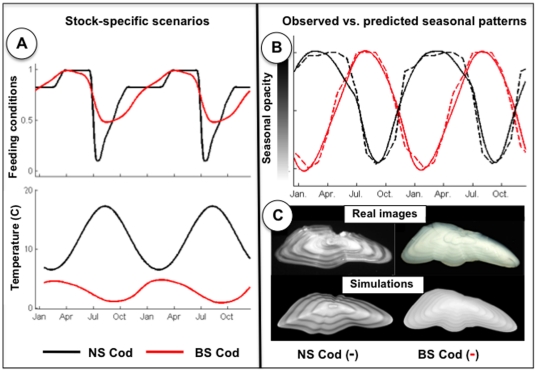
Resolving the non-synchronous seasonality of opacity patterns of Barents Sea (BS) and southern North Sea (NS) cod otoliths: Feeding and temperature conditions (panel A) that explain otolith opacity patterns observed for southern North Sea (NS, black) and Barents Sea (BS, red) cod (panels B and C).Observed seasonal patterns (dashed lines), given as the relative proportions of opaque edges in the monthly sampled otolith sets [21], are compared to normalized simulated opacity patterns (solid lines). Model simulations reproduce both the opposite seasonal opacity patterns (panel B) and the remarkable differences in the contrast of the otolith images of the two populations (panel C). The Supp. Mat. details the stock-specific scenarios (Text S1 & Fig. S5) and animated model simulations are provide as an electronic appendix (Video S1).